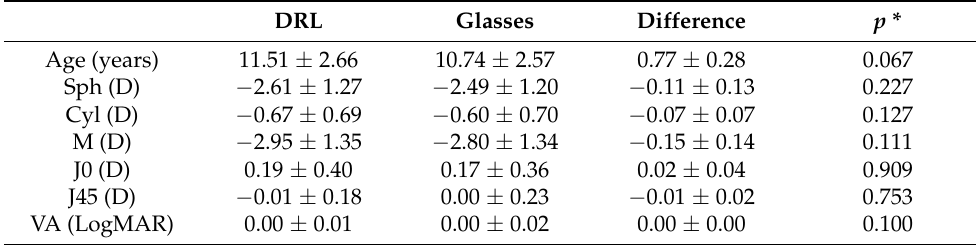
Table 2. Demographic data of quantitative variables at the beginning of treatment ( n =